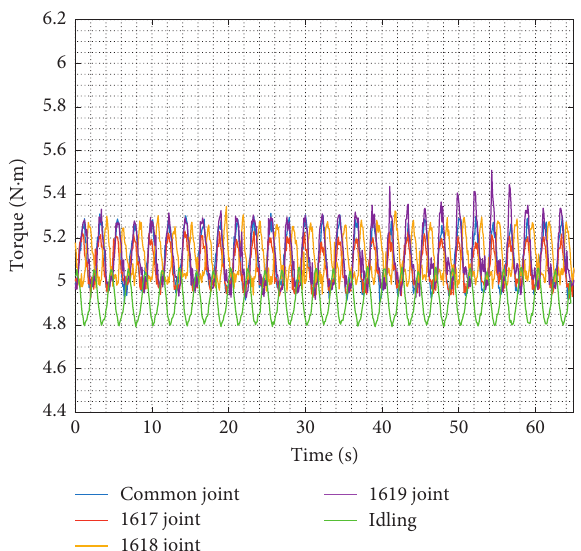
Figure 4: Linear trend of torque-time curves with a rotation speed of 30 r/min and a penetration rate of